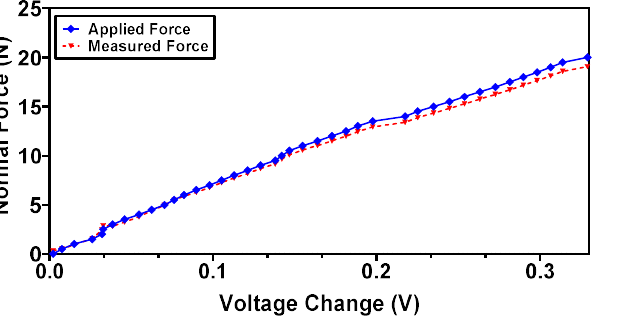
Figure 16. Measured vs. applied force in the normal direction using the back interpolation mathe- matical model.